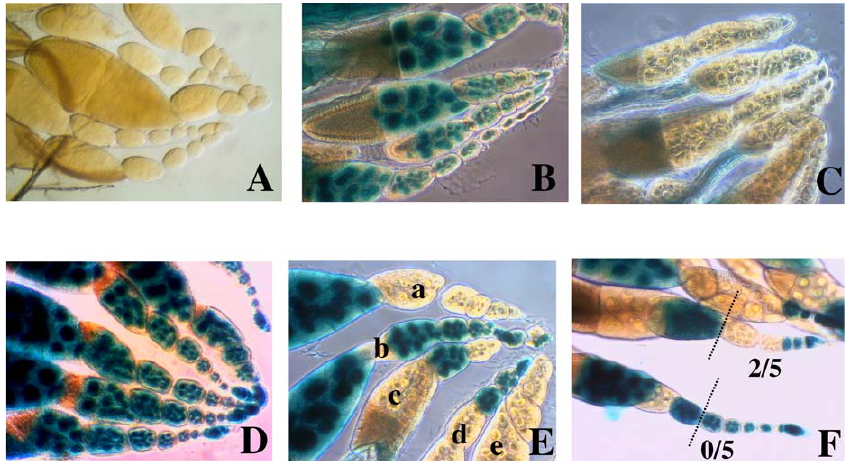
Figure 1. Phenotype and Quantification of TSE (A, B) Ovary b -galactosidase staining of P-lacZ enhancer-trap transgenes inserted in subtelomeric heterochromatin (line P-1152 [A]) and euchromatin (line BQ16 [B]) . (C) Complete repression of lacZ by TSE in the G 1 females produced by the cross between P-1152 females and BQ16 males. (D) Expression control of the euchromatic BC69 P-lacZ enhancer-trap. (E, F) Incomplete TSE in the G 1 females produced by the cross between P-1152 females and BC69 males. Variegation is observed inside ovaries that show individual ovarioles with both off ( lacZ repressed) and on ( lacZ not repressed) egg chambers (Ea, Ec, Ed) and ovarioles that are completely off (Ee) or completely on (Eb). (F) For the quantification of TSE, the number of repressed egg chambers among the first five egg chambers of a given ovariole is assayed. A total of ten ovarioles are scored per ovary for more than ten ovaries.